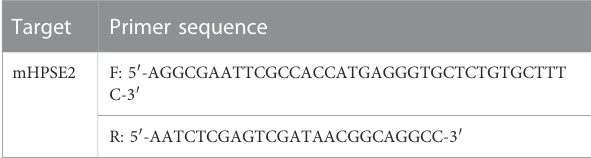
TABLE 2 Primers used in cloning